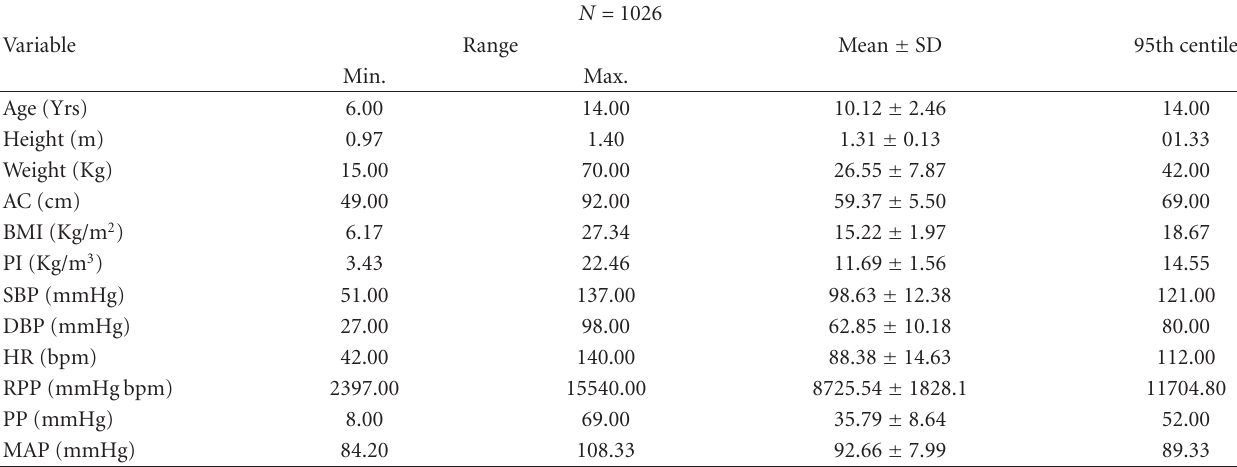
Table 1: Physical characteristics and resting physiological parameters of the subjects. N = 1026